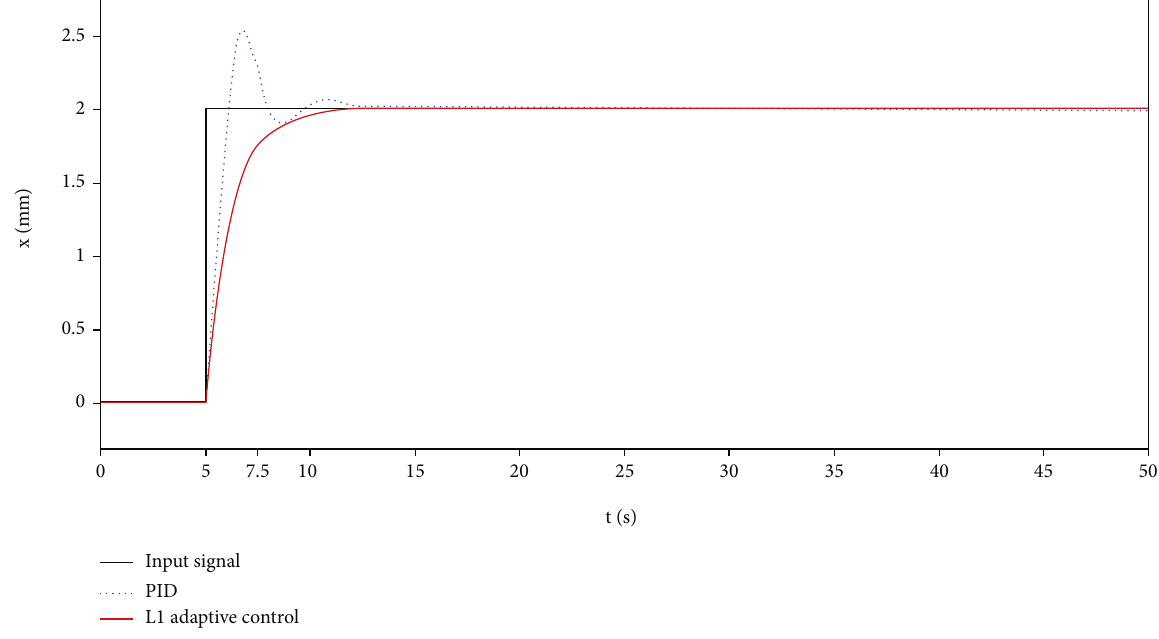
Figure 4: Track signal response when L1 has no interference.